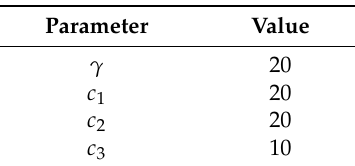
Table 2. The control